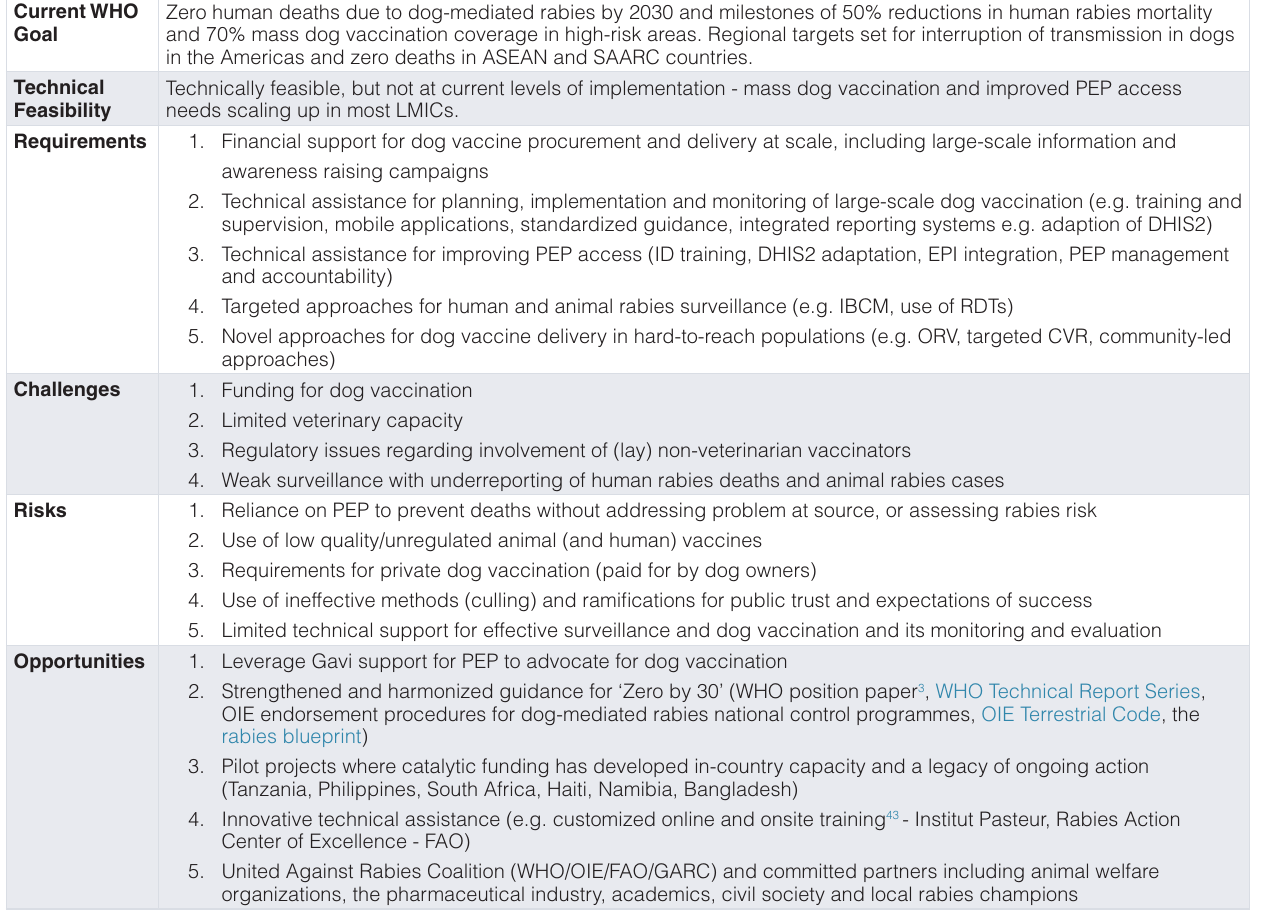
Table 1. Summary of challenges for reaching the neglected tropical diseases roadmap targets for rabies. Current WHO Goal